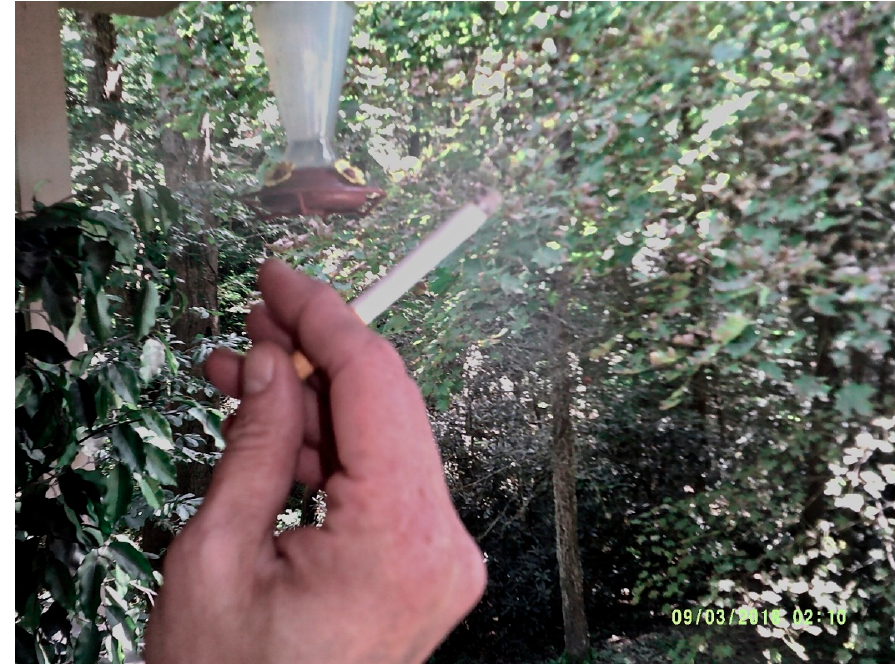
Figure 6. Cigarette smoking on the back porch.